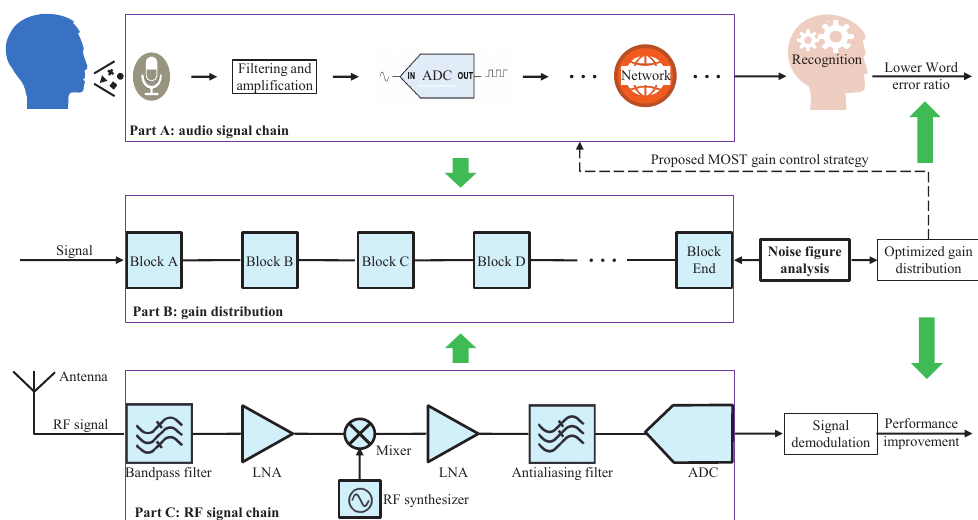
Figure 5. Principles of modeling and analysis of gain control